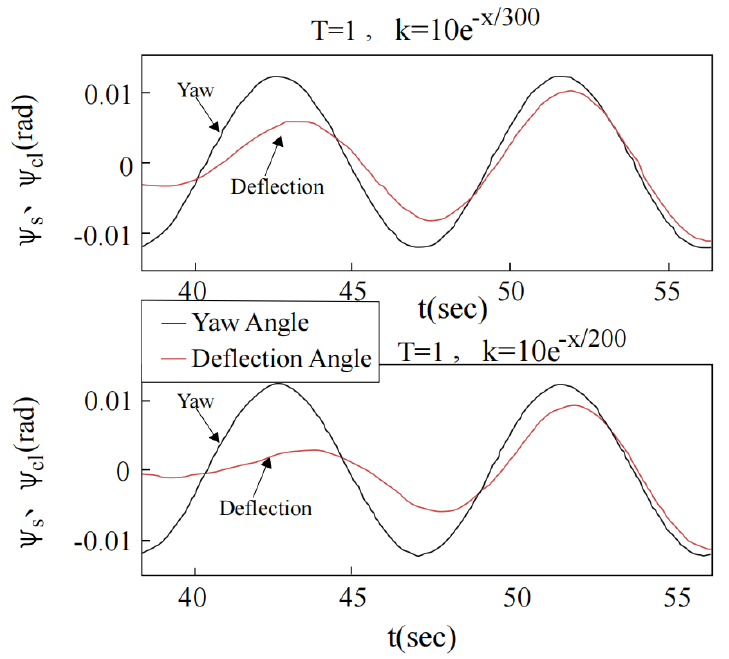
Figure 37. The deck motion compensation curves under inertial tracking strategies with different k values.